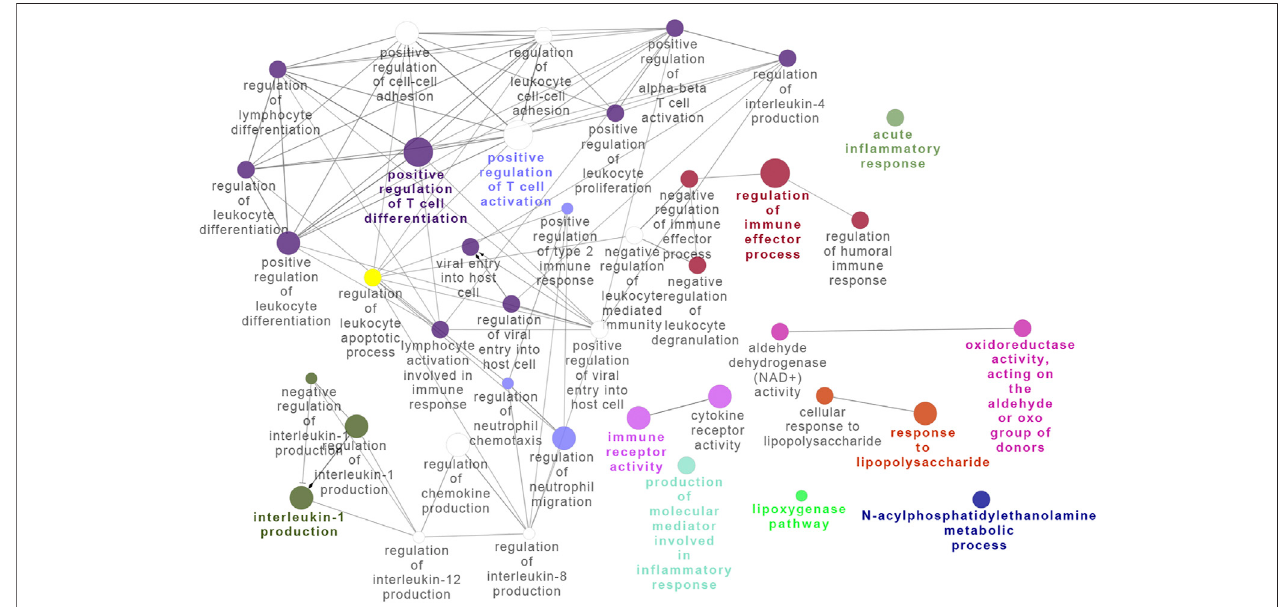
FIGURE 5 | Integrated network analysis of BRD4-dependent genes. Gene pathway interaction map of BRD4-dependent genes. Note the striking enrichment of T-cell differentiation and activation of immune effector processes.